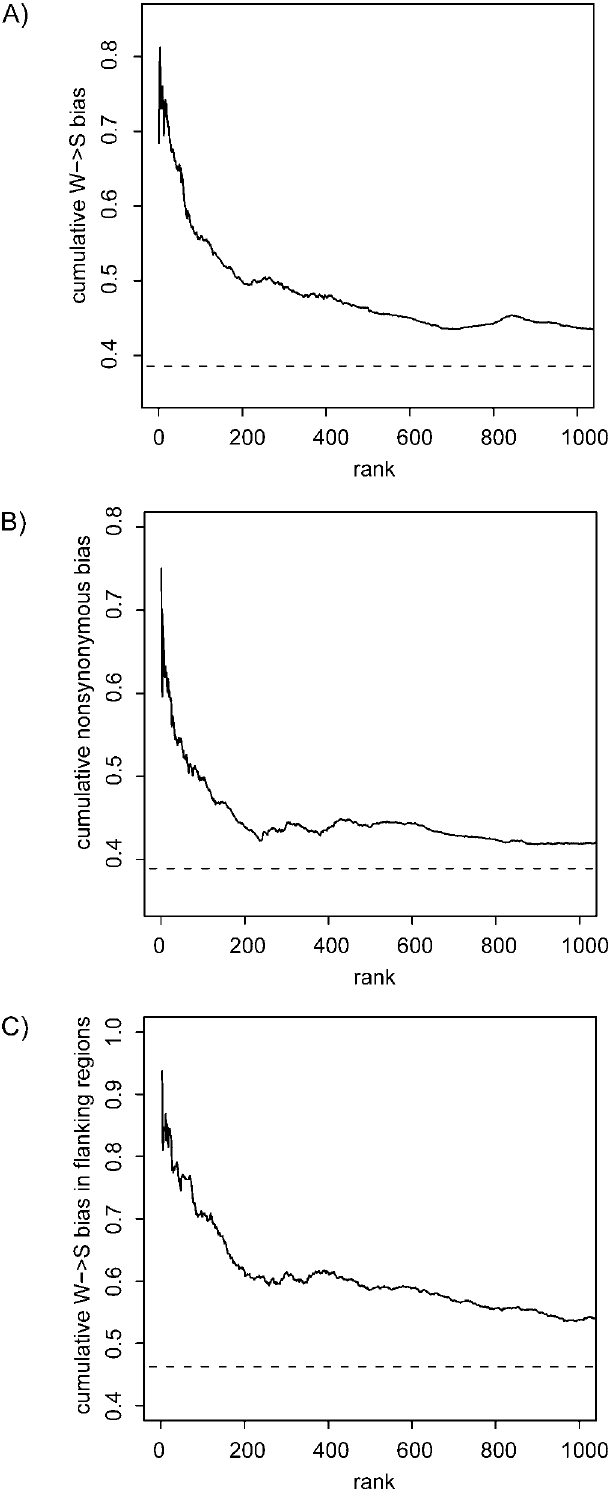
Figure 1. Cumulative Bias in Different Classes of Nucleotide Substitu- tions in the Exons with the Highest Degree of Acceleration on the Human Lineage (A) The proportion of W ! S substitutions compared to W ! S and S ! W substitutions on the human lineage. (B) The proportion of nonsynonymous substitutions compared to all substitutions in each gene on the human lineage. (C) The proportion of W ! S substitutions compared to W ! S and S ! W substitutions on the human lineage in the flanking noncoding regions. Dashed lines represent averages for the entire dataset. doi:10.1371/journal.pbio.1000026.g001 PLoS Biology |